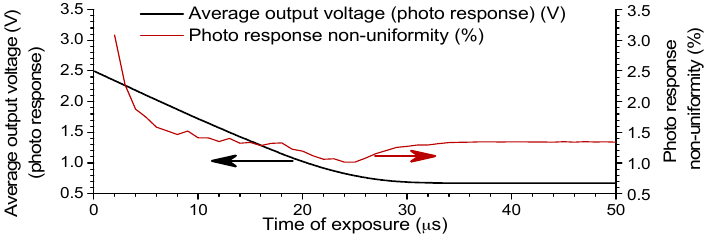
Figure 6. The measured photo response curve and the photo response non-uniformity of the designed image sensor.